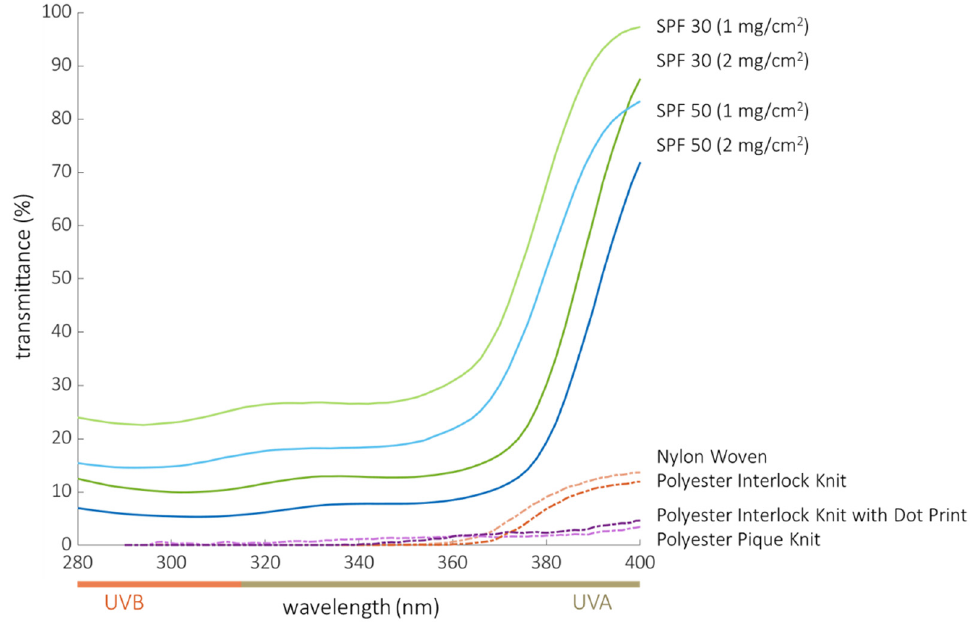
Figure 3. Transmittance curves of the two commercial sunscreens applied at 2 mg/cm 2 and 1 mg/cm 2 compared to curves of the four fabrics tested. Each curve is an average of multiple measurements.